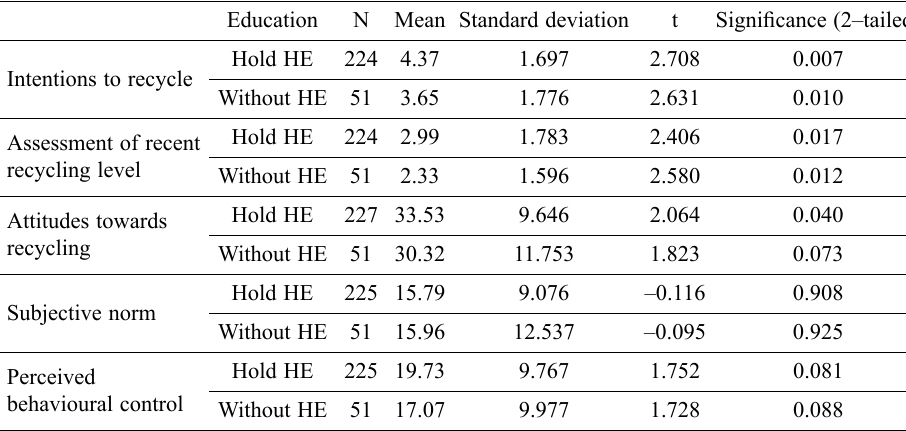
Table 5. Differences in intentions to recycle, recent recycling behaviour, attitude towards recycling, subject norm and PBC between people holding higher education and not holding higher education